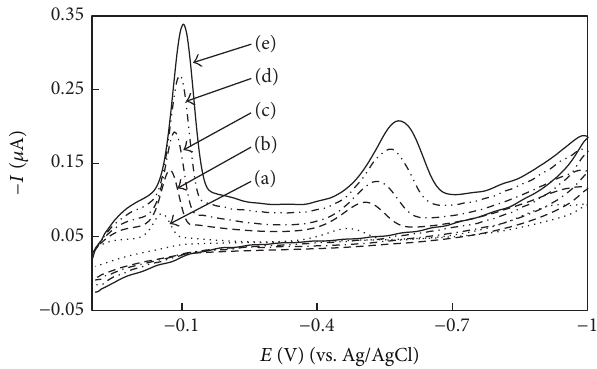
Figure 3: Cyclic voltammograms for 5.0 × 10 −6 mol L −1 NT solution in Britton-Robinson buffer (pH = 2.5) at the scan rates (a) 20, (b) 75, (c) 150, (d) 300, and (e) 500 mVs −1